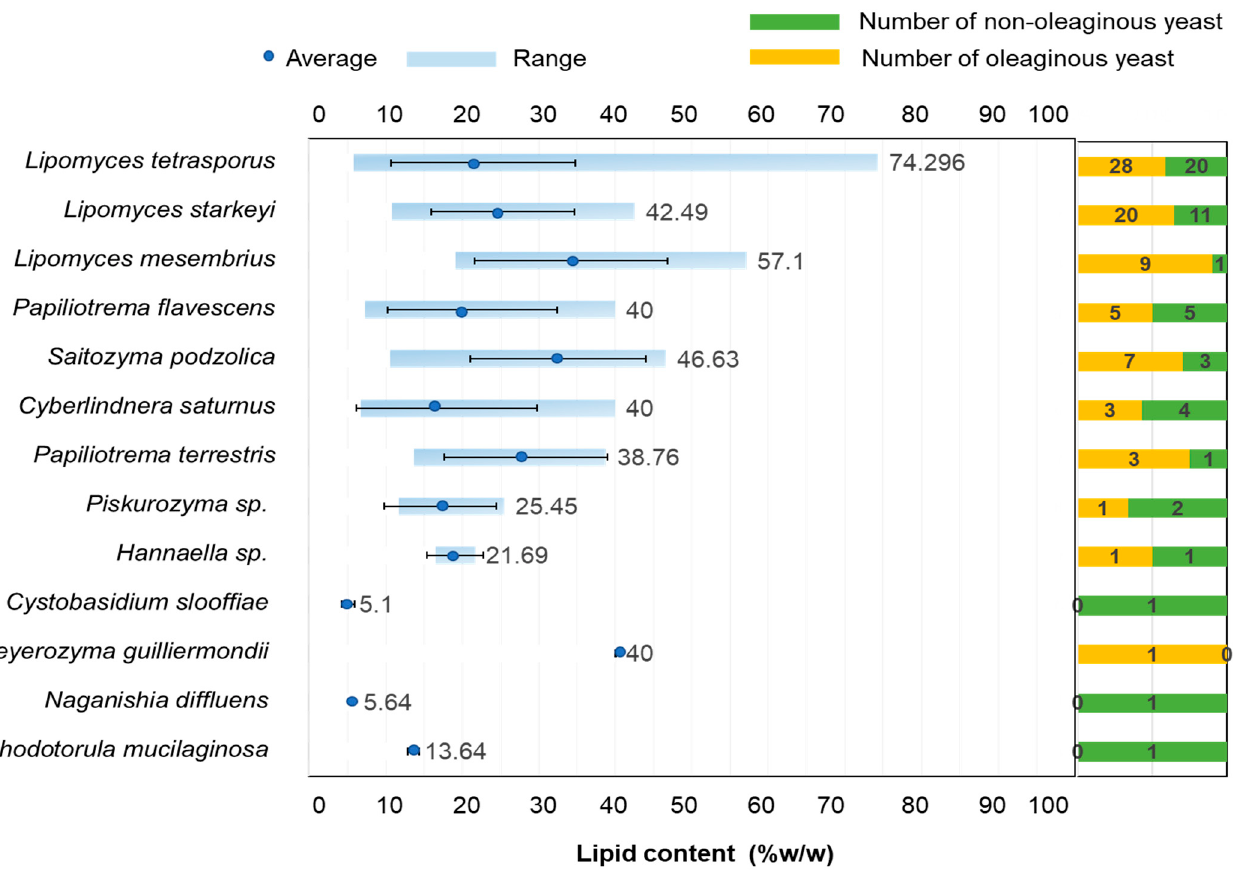
Figure 5. Summary of 13 species isolated from forest soil on the mountains in Thailand. The range of the highest lipid content including average and standard deviation (blue bar), as well as the number of oleaginous yeasts (yellow bar) and the number of non-oleaginous yeasts (green bar), are shown.